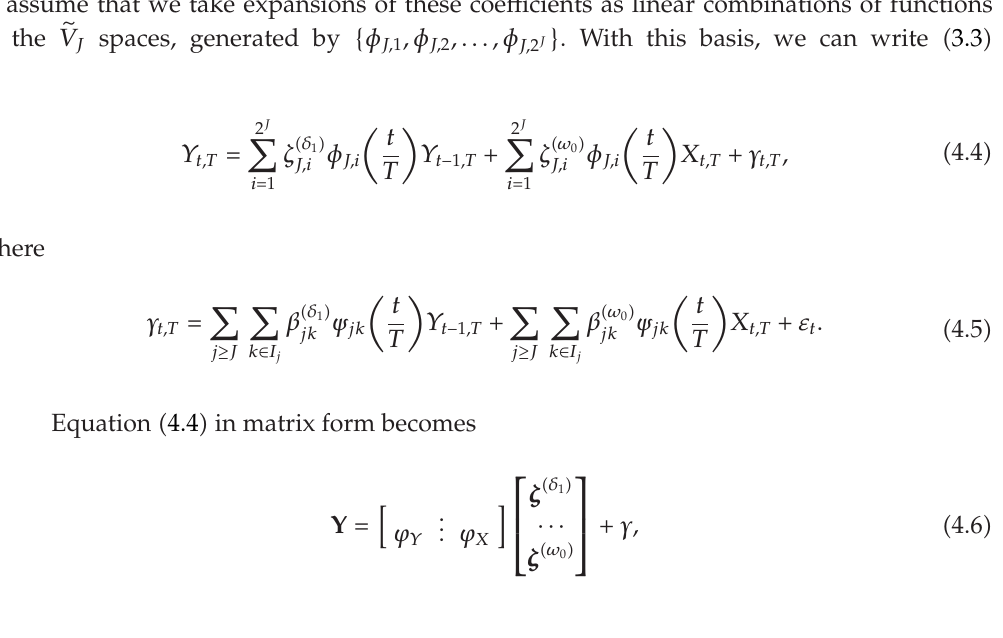
(cid:7) δ (cid:5) · (cid:6) , (cid:5) c (cid:6) (cid:7) w (cid:5) · (cid:6) and nonlinear estimators (cid:5) b (cid:6) (cid:5) δ 1 0